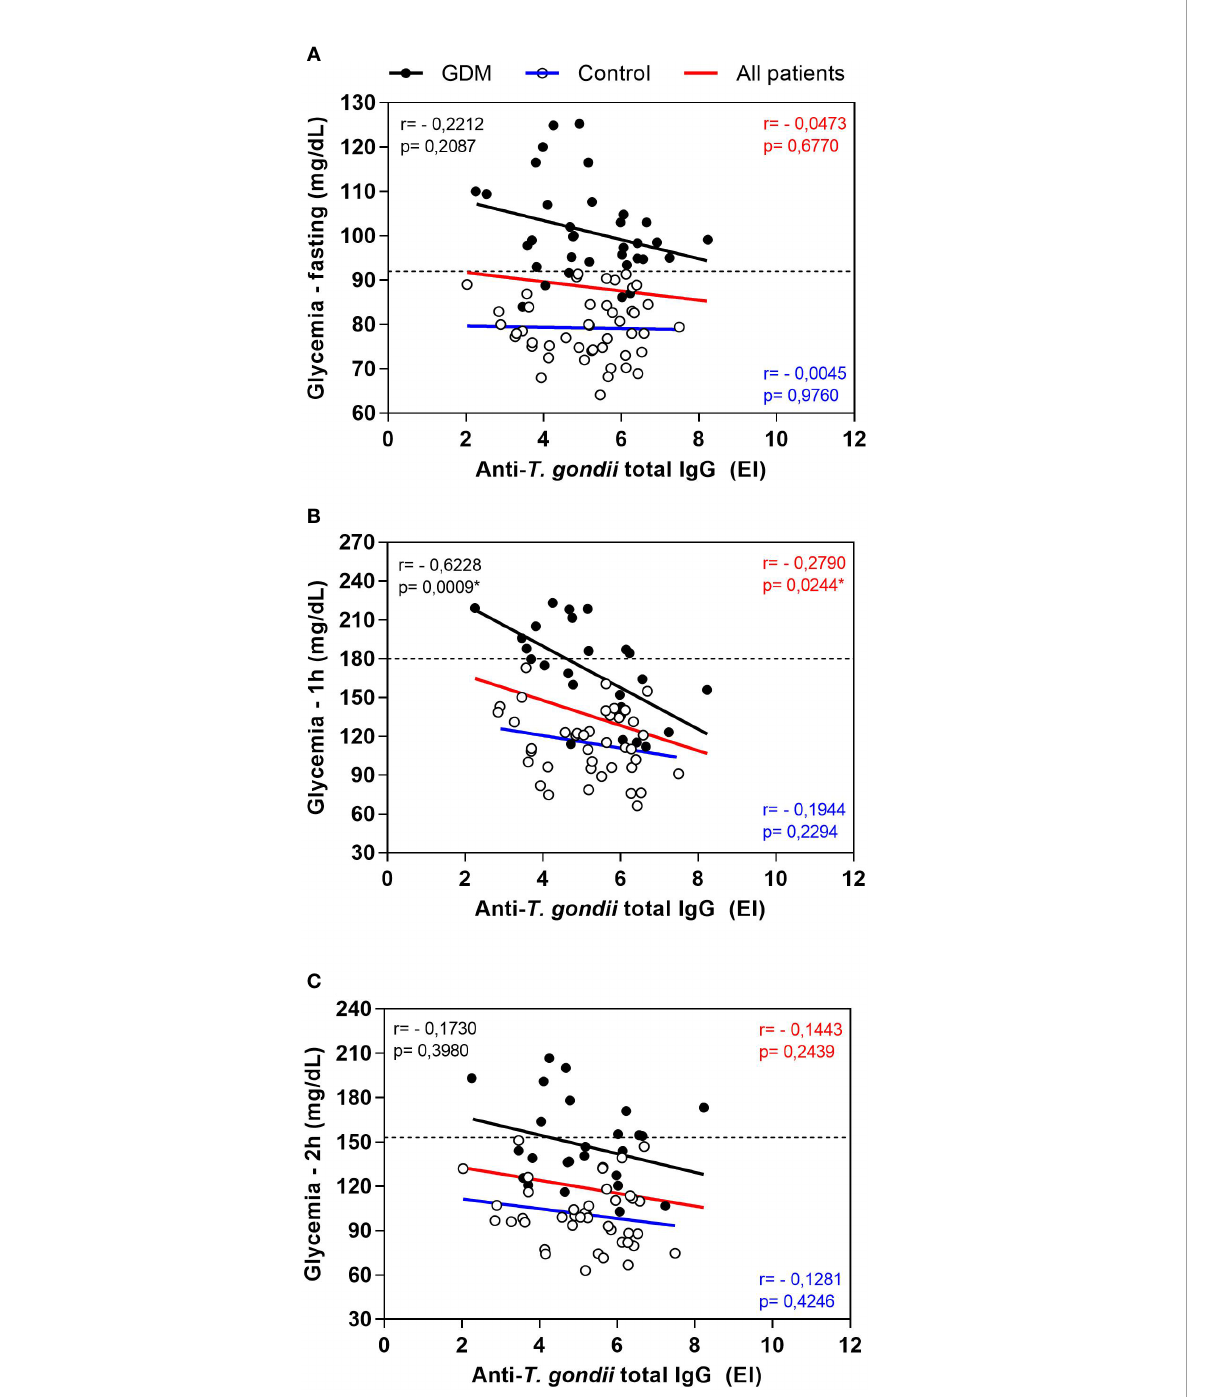
FIGURE 2 Correlation between oral glucose tolerance test (OGTT) blood glucose values and anti- T. gondii total IgG levels of pregnant women, from the GDM group, control group and all patients. (A) Fasting blood glucose, (B) glycemia one hour after dextrose and (C) glycemia two hours after dextrose. The dashed lines represent the cut-off values for the diagnosis of gestational diabetes mellitus (Fasting > 92 mg/dL; one hour ≥ 180 mg/dL, two hours ≥ 153 mg/dL). *Statistically signi fi cant data, Spearman correlation test. EI: ELISA Index. GDM: Gestational diabetes